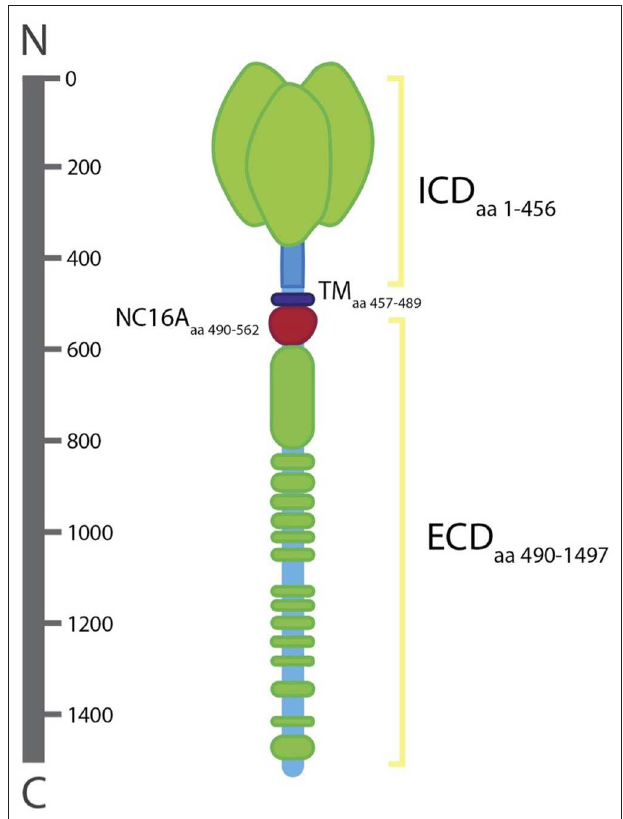
FIGURE 2 | Structure of collagen XVII. The intracellular domain (lCD; aa 1–456), transmembrane domain (TD; aa 457–489), and extracellular domain (ECD; aa 490–1497). The ECD includ es the NC16A domain (aa 490–562). The ICD lies in the outer plaque of the HD and the ECD spans the lamina Iucida, extends to the lamina densa, and loops back into the lamina Iucida.